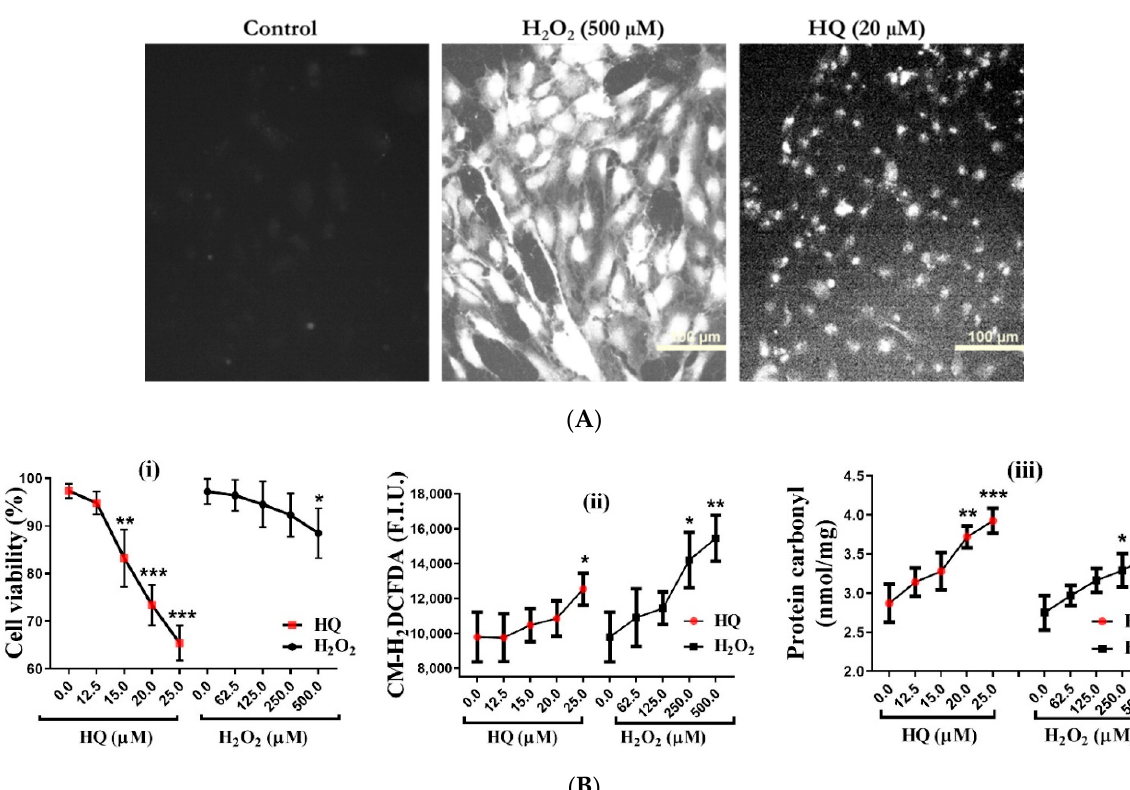
Figure 1. ARPE-19 cells are vulnerable to hydroquinone (HQ)-induced oxidative damage. ( A ) Live-cell confocal microscopy for intracellular reactive oxygen species (ROS) using CM-H2DCFDA dye after incubation of cells with HQ or H 2 O 2 for 2 h. Basal ROS level in the control is barely visible compared to H 2 O 2 treatment or HQ upon calibration. ( B ) Quantification of the (i) cell viability by Trypan blue dye exclusion assay, (ii) ROS levels, and (iii) protein carbonyl levels by fluorescent spectrometry using a microplate reader following incubation with HQ or H 2 O 2 for 2 h. Data represent the mean (+standard deviation, SD) of 3 independent experiments of 3 replicates each. Statistical analysis was performed by one-way ANOVA followed by Dunnett’s multiple comparison tests. * p < 0.05, ** p < 0.01, *** p < 0.001, significant difference relative to the controls. Fluorescence intensity units